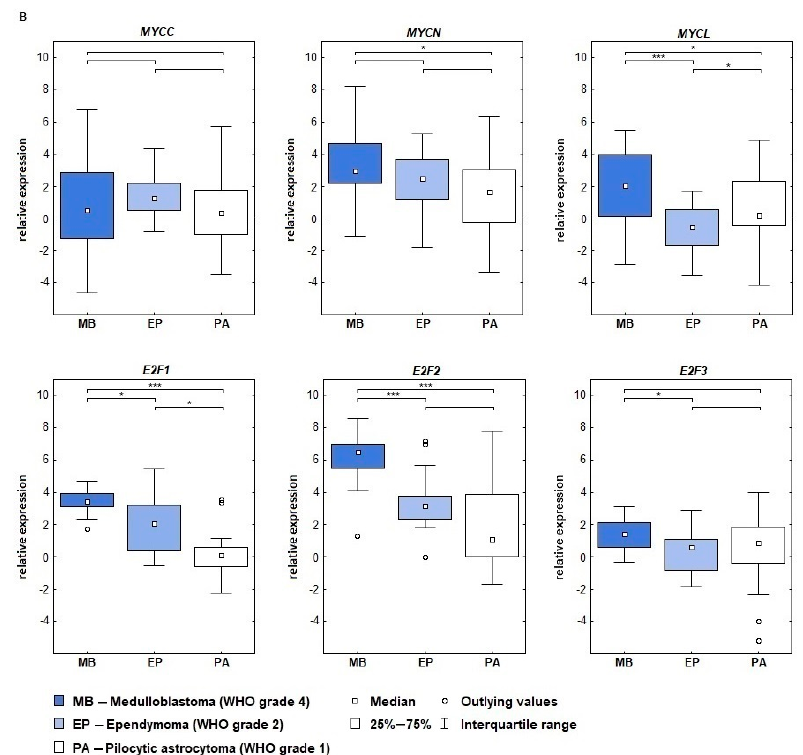
Figure 1. Expression of genes from the MYC and E2F families in three groups of pediatric brain tumors: medulloblastomas, ependymomas, and pilocytic astrocytomas. ( A ) Relative expression of MYCC , MYCN , MYCL , E2F1 , F2F2, and E2F3 genes given in ddCt values. ( B ) Relative expression of MYCC , MYCN , MYCL , E2F1 , F2F2, and E2F3 with an indication of the differences in expression between the groups studied; * p < 0.05, *** p < 0.001. Table 1. p values determining the level of statistical significance in gene expression from MYC and E2F families between the analyzed groups. If p value is less than 0.05 we report the result as statistically significant (indicated in bold). MB, medulloblastoma; EP, ependymoma; PA, pilocytic astrocytoma. Gene MB vs. PA MB vs. EP EP vs. PA MYCC 0.788019 0.471420 0.164877 MYCN 0.012457 0.375058 0.535525 MYCL